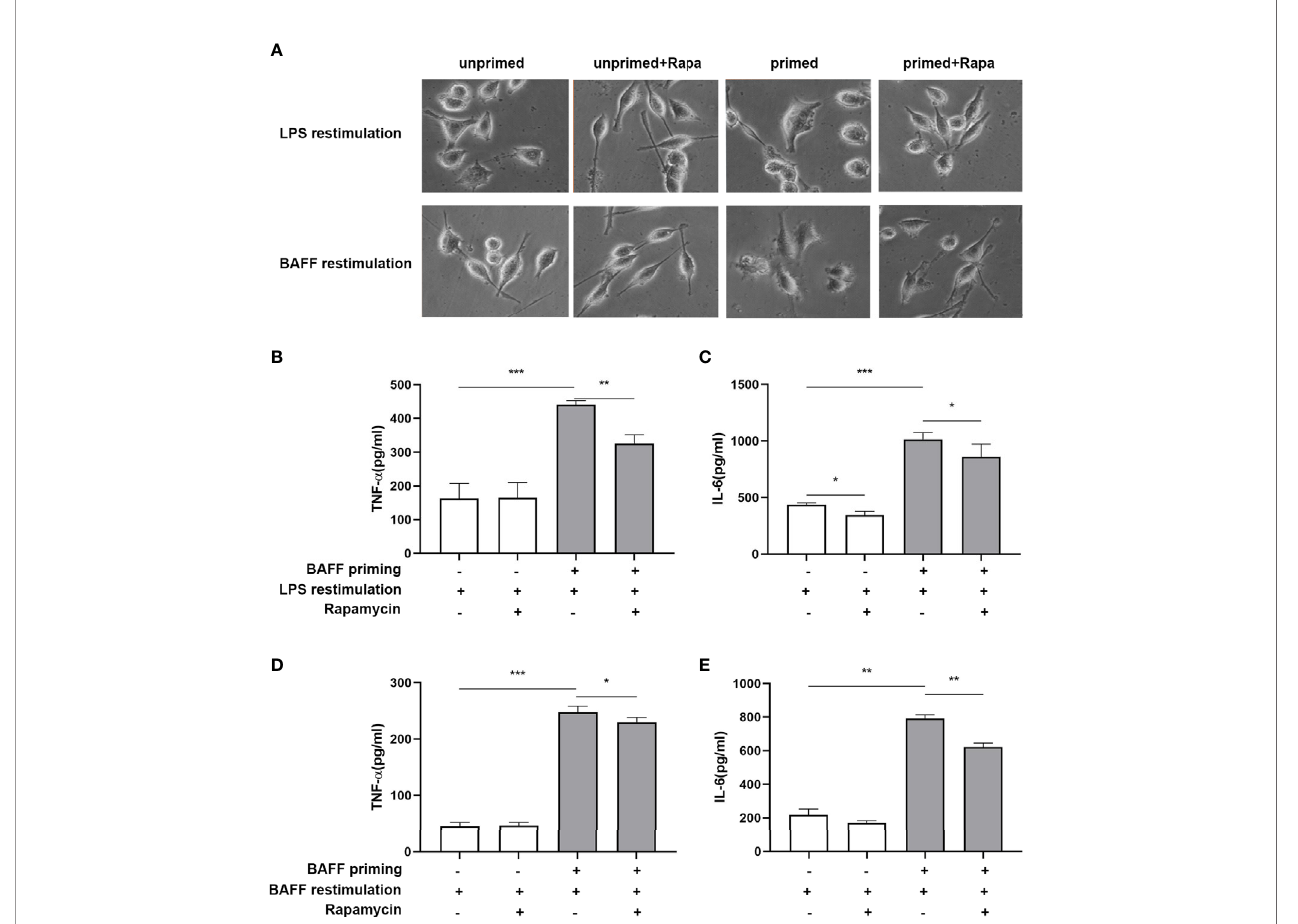
FIGURE 7 | Rapamycin inhibited BAFF-induced trained immunity phenotype of BV2 cells. BV2 cells were pretreated with 100 nM rapamycin for 1 h, then primed with vehicle or BAFF for 24 h. After a rested of 5 days, cells were restimulated with BAFF or LPS for 24 h. (A) Representative micrographs of BV2 cells on day 7(n = 9). The amounts of TNF- a (B) and IL-6 (C) were measured in the culture supernatants on day 7 upon LPS restimulation (n = 12). The amounts of TNF- a (D) and IL- 6 (E) were measured in the culture supernatants on day 7 upon BAFF restimulation (n = 12). Data are mean ± SEM; Kruskal-Wallis test with Turkey post hoc test; *p < 0.05, **p < 0.01, and ***p <